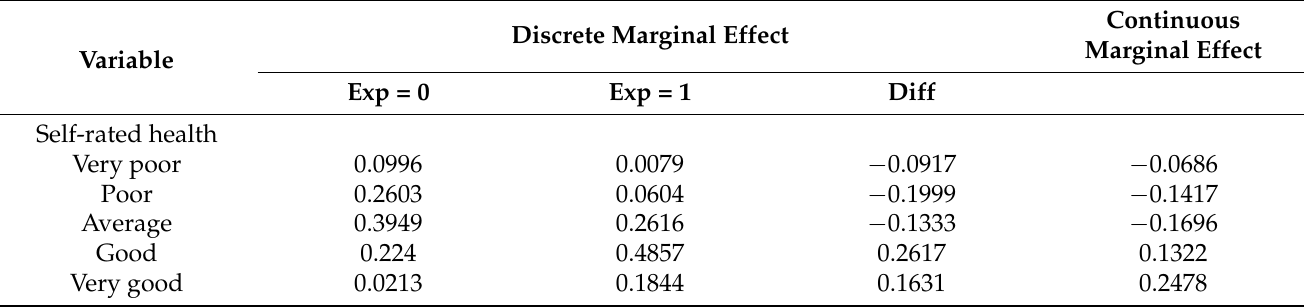
Table 6. The discrete and continuous marginal effects of the smog avoidance investment decision on self-rated